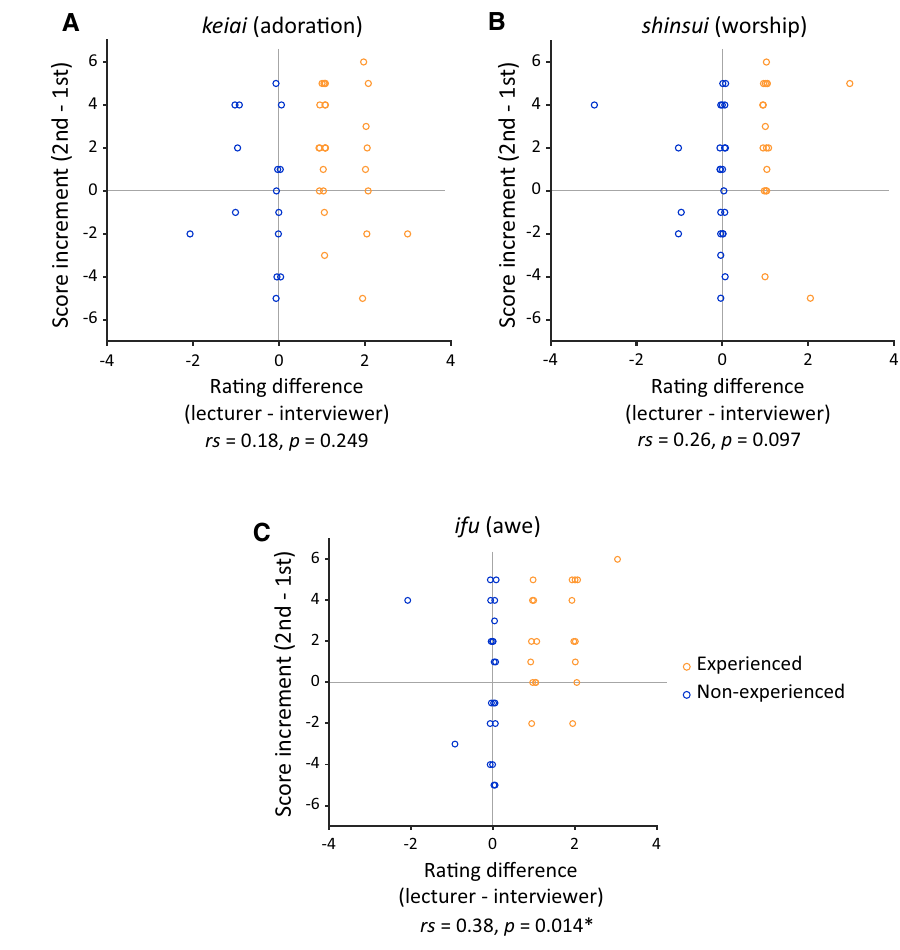
Fig. 4 The scores for the first and second exams when classifying participants into admiration/respect-experienced and non-experienced groups. A The scores of admiration-experienced and non-experienced participants. Participants in the experienced group on average rated the lecturer higher than the interviewer in the admiration subcategories of kanshin and kyotan . A mixed ANOVA revealed that there were no significant effects of exam or group, and no significant interaction. B The scores of respect-experienced and non-experienced participants. The experienced group on average rated the lecturer higher than the interviewer in the respect subcategories of keiai , shinsui , and ifu . We performed a mixed ANOVA and found that the interaction effect of exam and group was significant, with no effects of exam or group. According to the subsequent analyses, the experienced group improved their scores significantly while the non-experienced group did not. There was no significant difference between groups for the first or second exam. Error bars indicate the standard error across participants